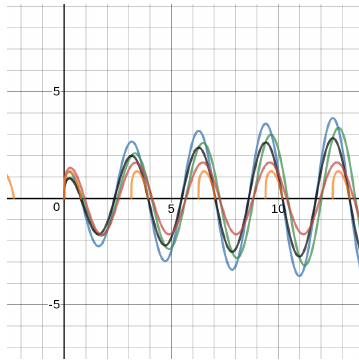
Figure 1. red:Caputo, green:Khalil et al. , blue:Anderson et al. , orange:Guebbai et al. , black:GFD when w t , α = α